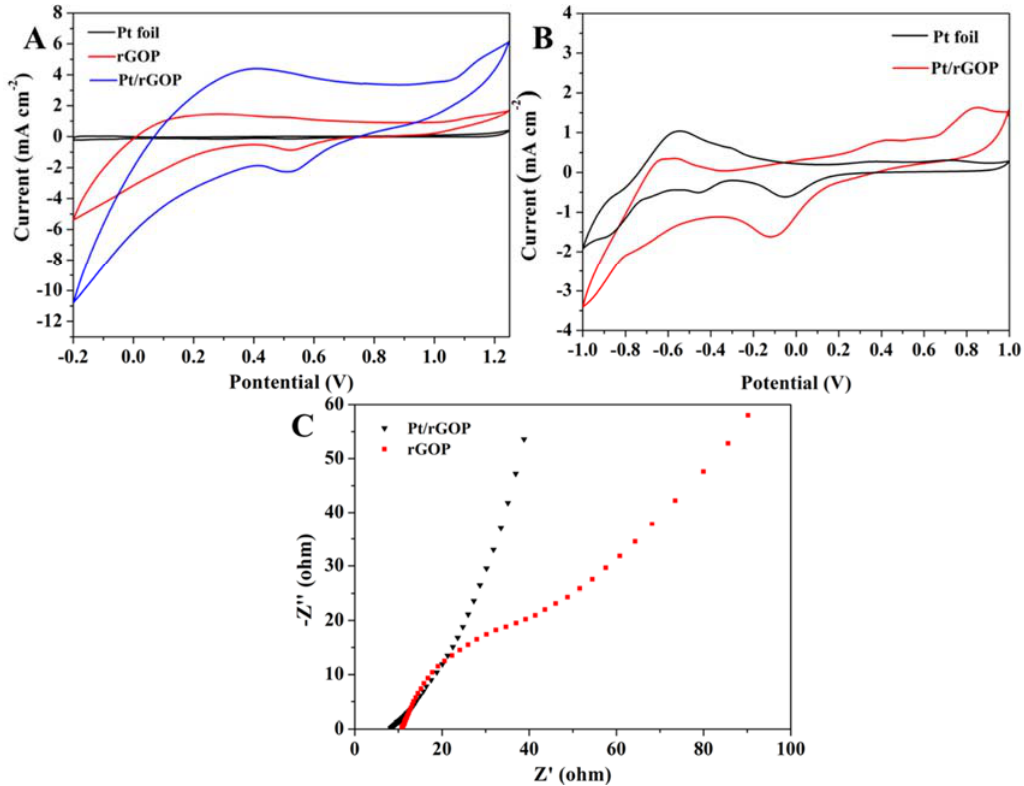
Figure 6. CV curves of ( A ) Pt foil, rGOP and Pt/rGOP in deaerated 0.5 mol/L H 2 SO 4 with a scan rate of 50 mV/s, and ( B ) Pt foil and Pt/rGOP in 0.1 mol/L PBS containing 1.0 mmol/L H 2 O 2 saturated with nitrogen gas. ( C ) Nyquist plots of Pt/rGOP, rGOP electrodes in deaerated 0.1 mol/L KCl, containing